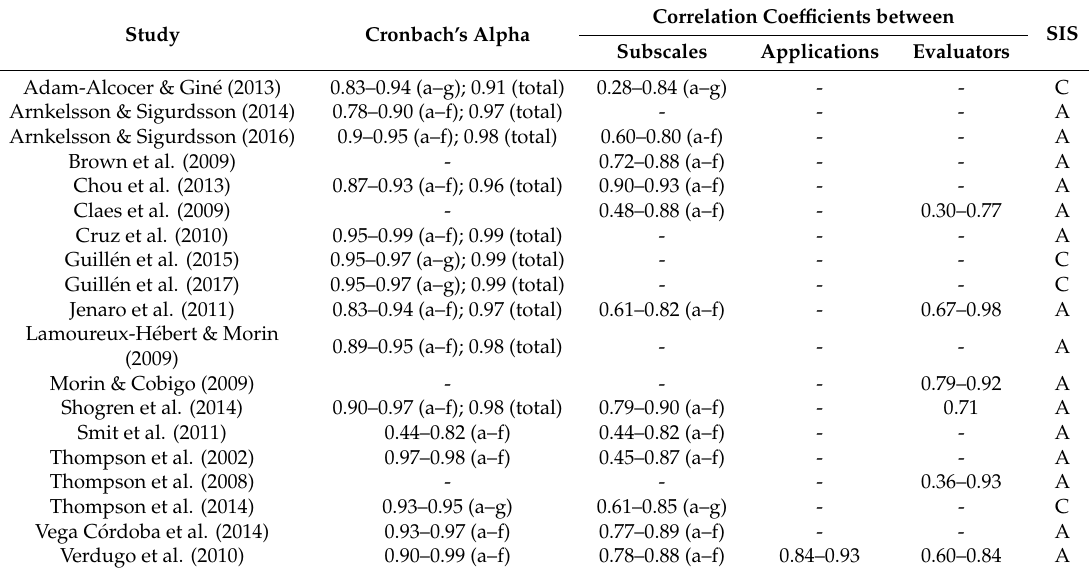
Table A1. Association Indices Between Areas of Support